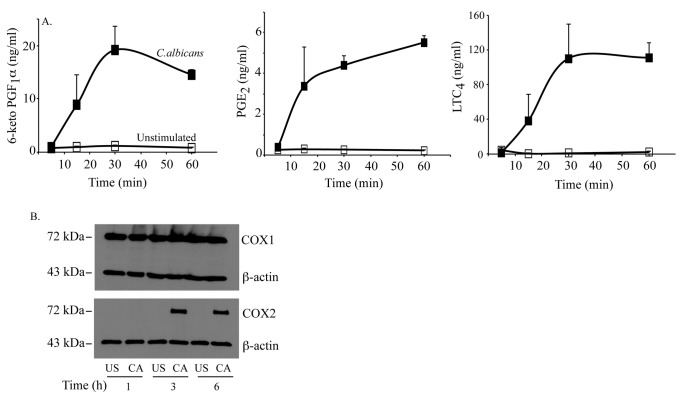
Time course of C.
albicans-stimulated eicosanoid
production.(A) RPM were incubated with C. albicans
for the indicated times. The culture medium from unstimulated (open squares)
or C.
albicans-stimulated (closed squares) RPM
was analyzed for eicosanoids by mass spectrometry. The data are the average
of triplicate samples (±S.D.) from a representative experiment. (B) Cell
lysates from unstimulated RPM (US) or RPM stimulated with
C.
albicans (CA) for 1, 3 and 6 h were
analyzed for COX1 and COX2 expression by Western blotting. Sample loading
was evaluated by probing with antibodies to β-actin.